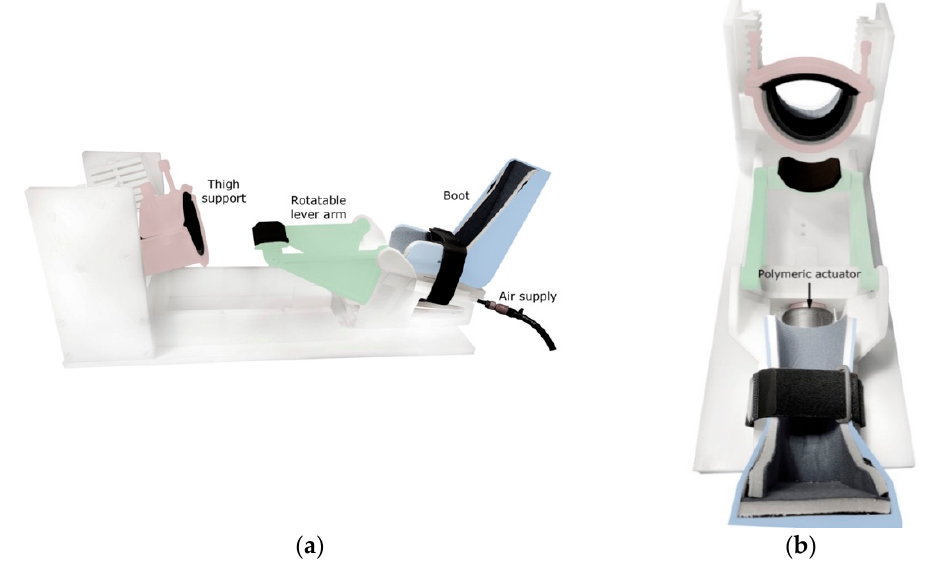
Figure 1. Pneumatic knee loading device as seen from the side ( a ) and top ( b ). Note the polymeric actuator beneath the boot.